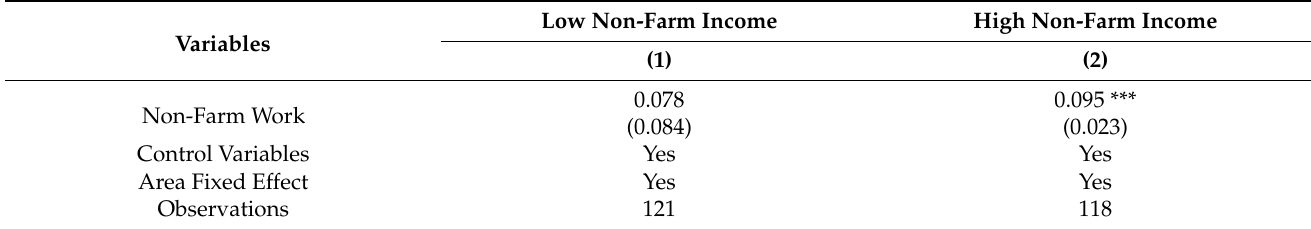
Table 7. Marginal Effects of Women’s Non-Farm